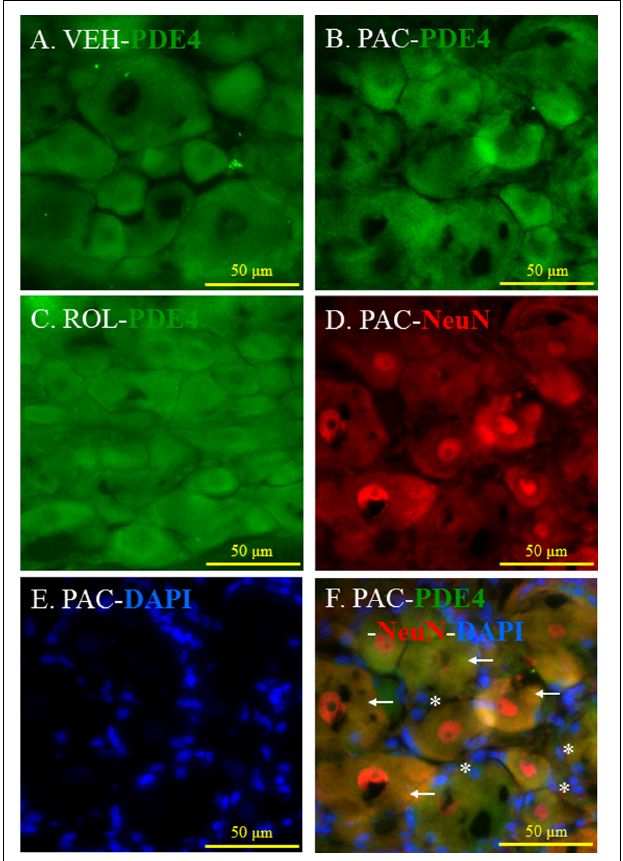
FIGURE 4 | (Representative immunofluorescent images of IL-1 β ) Co-localization of IL-1 β , NeuN, and GFAP in DRGs. (A) IL-1 β (green, Alexa Fluor 488) in the L5 DRG of a vehicle (VEH; 4% dimethyl sulfoxide and 4% Tween 80 in saline)-injected rat. (B) IL-1 β (green, Alexa Fluor 488) in the L5 DRG of a paclitaxel (PAC; 2 mg/kg/1 ml of vehicle)-injected rat. (C) IL-1 β (green, Alexa Fluor 488) in the L5 DRG of a paclitaxel + rolipram (ROL; 3 mg/kg)-injected rat. (D) IL-1 β (green, Alexa Fluor 488) and NeuN (red, Alexa Fluor 568) in the L5 DRG of a paclitaxel-injected rat. (E) IL-1 β (green, Alexa Fluor 488) and GFAP (red, Alexa Fluor 568) in the L5 DRG of a paclitaxel-injected rat. (F) Quantification of IL-1 β in the DRG. Paclitaxel increased the levels of IL-1 β in the DRG, and subsequent treatment with rolipram decreased that. The L5 DRGs of rats in the VEH ( N = 3) and PAC groups ( N = 3) were obtained on day 20 after the first paclitaxel injection. For rats in the ROL group, L5 DRGs were obtained 1 h after intraperitoneal injection of rolipram (3 mg/kg on day 20). Rolipram decreased the PAC-increased IL-1 β intensity in the DRG. Stars and arrows indicates satellite cells and neurons, respectively. Scale bars, 50 µ m. The data are expressed as means ± standard error for three rats. The asterisks indicate values that are significantly different ( P < 0.05) from the values for the vehicle group or PAC + ROL group as determined by the Mann–Whitney U